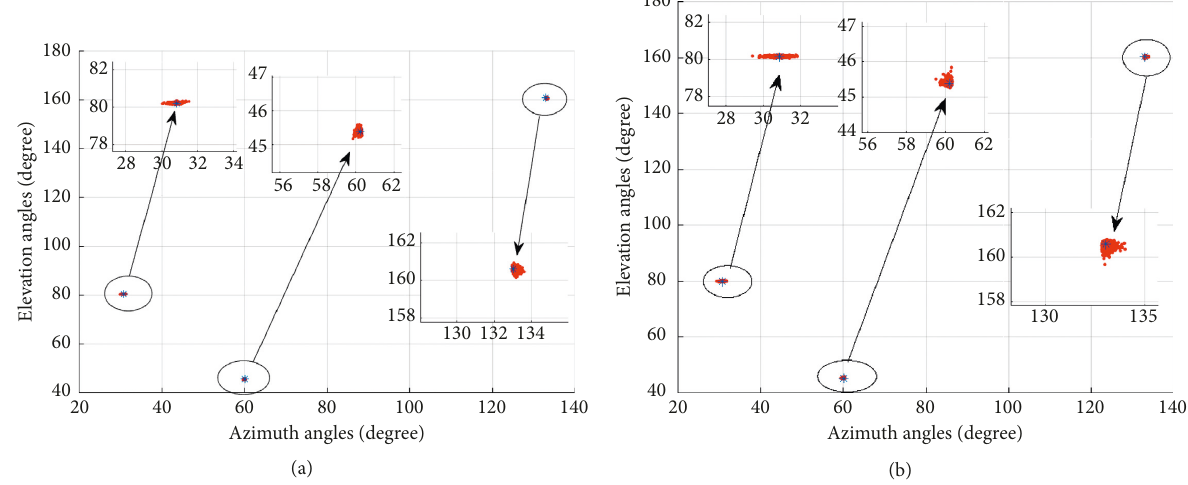
Figure 2: The scatters of 2-D DOA estimation with (a) the subspace-like method and (b) EAET.